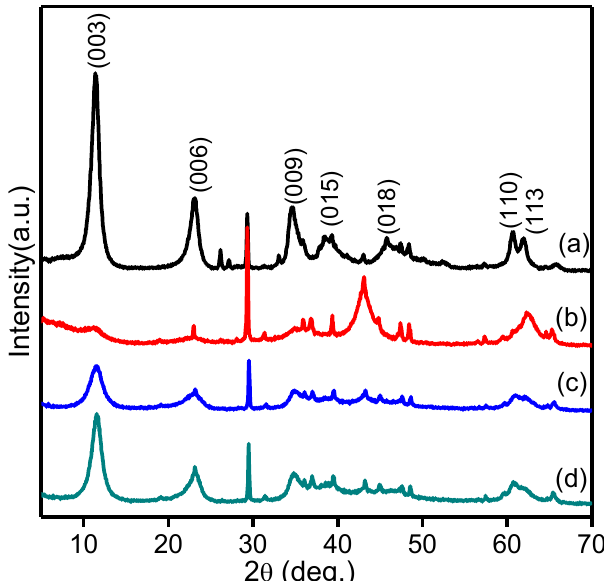
Figure 3. XRD patterns of ( a ) Mg-Ca-Al-LDH, ( b ) Mg-Ca-Al-LDO, ( c ) Mg-Ca-Al-LDO after Cr adsorption and ( d ) Mg-Ca-Al-LDO after EBT adsorption.